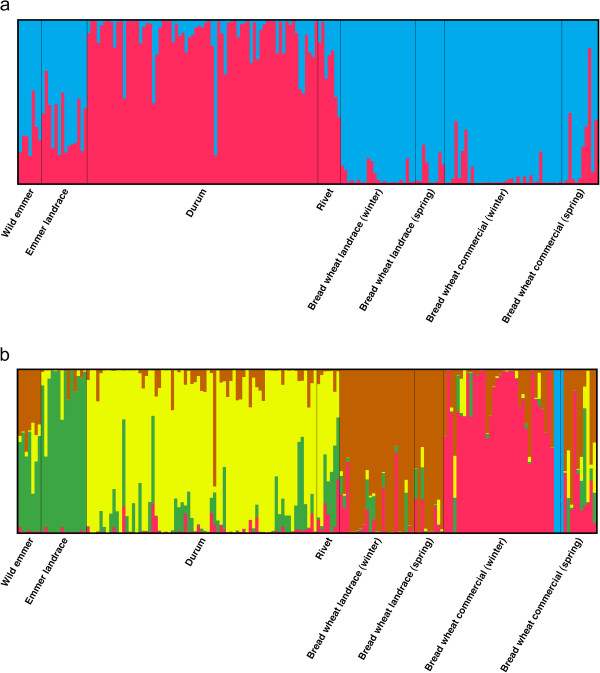
Results of Structure analysis of the complete set of wheat accessions based on 369 SNPs for a) K = 2 model, b) K = 5 model.